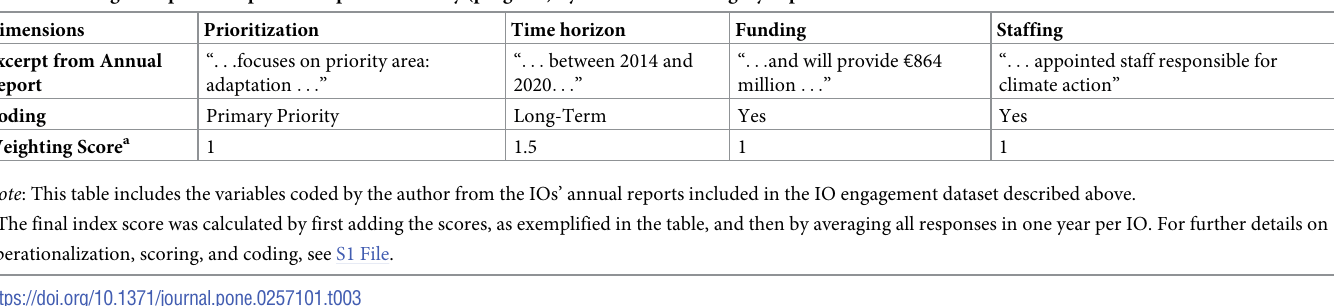
Table 3. Coding example for a specific adaptation activity (program) by the EU in the category “operational”.